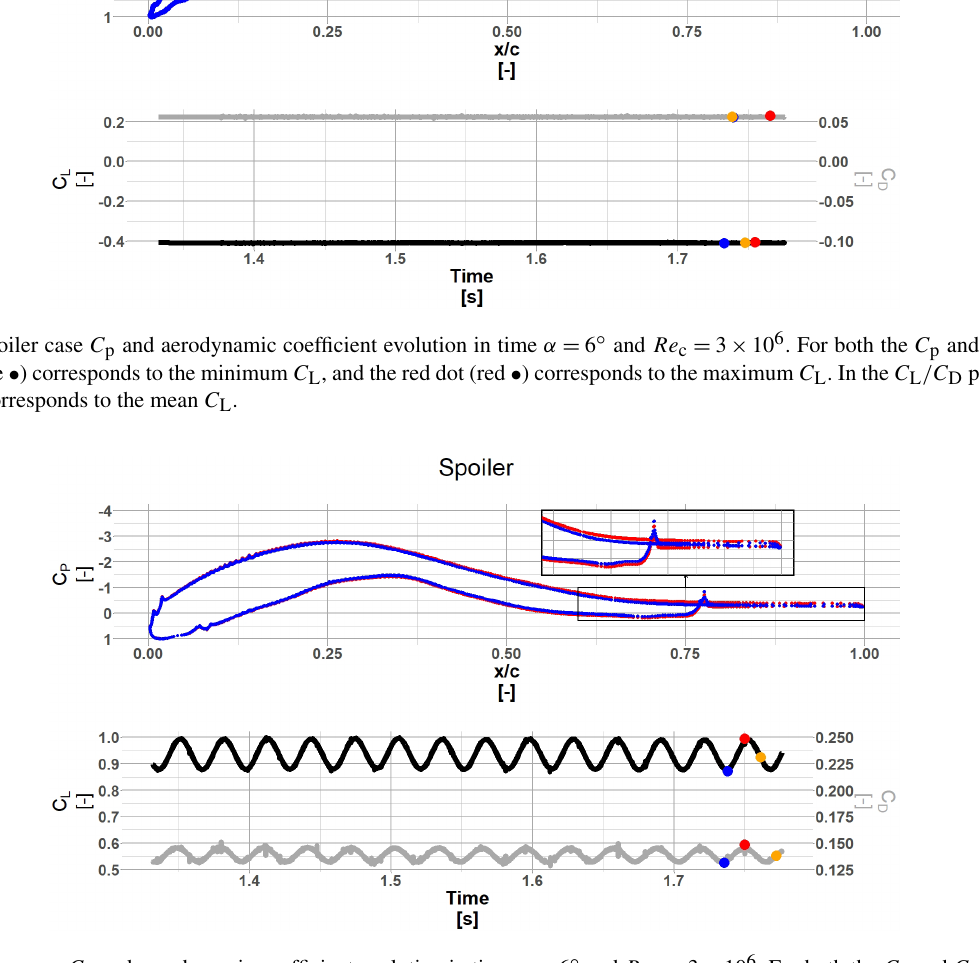
Figure 10. Spoiler case C p and aerodynamic coefficient evolution in time α = 6 ◦ and Re c = 3 × 10 6 . For both the C p and C L /C D plot, the blue dot (blue • ) corresponds to the minimum C L , and the red dot (red • ) corresponds to the maximum C L . In the C L /C D plot the orange dot (orange • ) corresponds to the mean C L